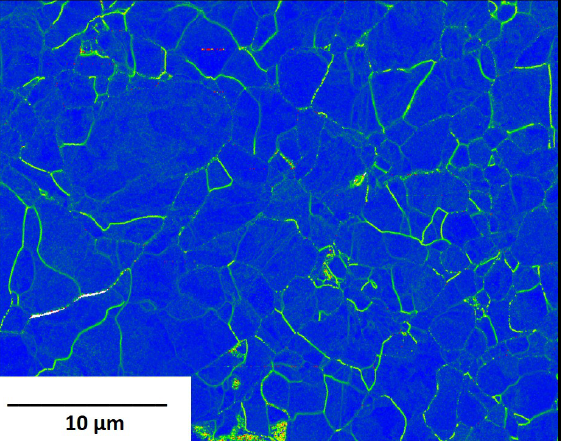
Figure 3. KAM map for traditionally manufactured